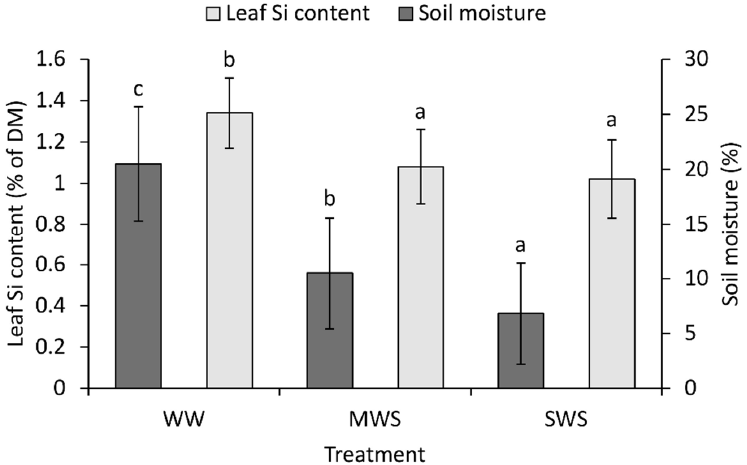
Figure 2. Soil moisture content for the three water treatments during the experimental period. The data are means ± SD ( n = 30). Different letters indicate significant differences across the treatments within each sampling day ( p ≤ 0.05; Duncan tests).